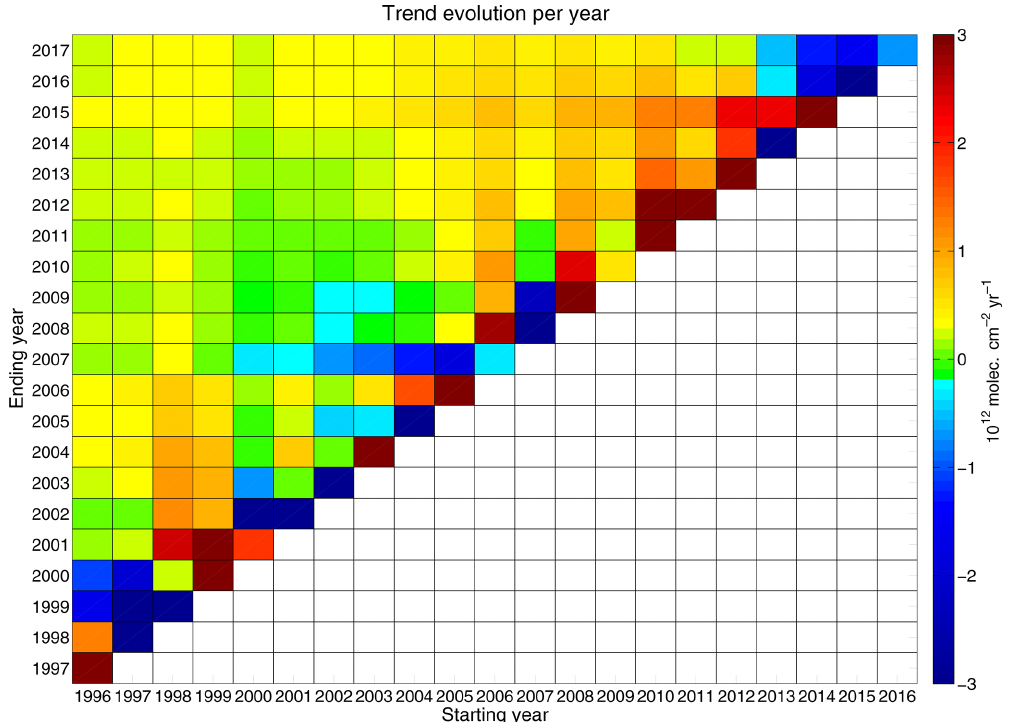
Figure 12. Trend (10 12 moleccm − 2 yr − 1 ) evolution of the merged tropospheric BrO dataset (i.e., slope of the linear regression line) over sea ice. The x axis shows the starting year and the y axis shows the ending year of the period over which the trend was